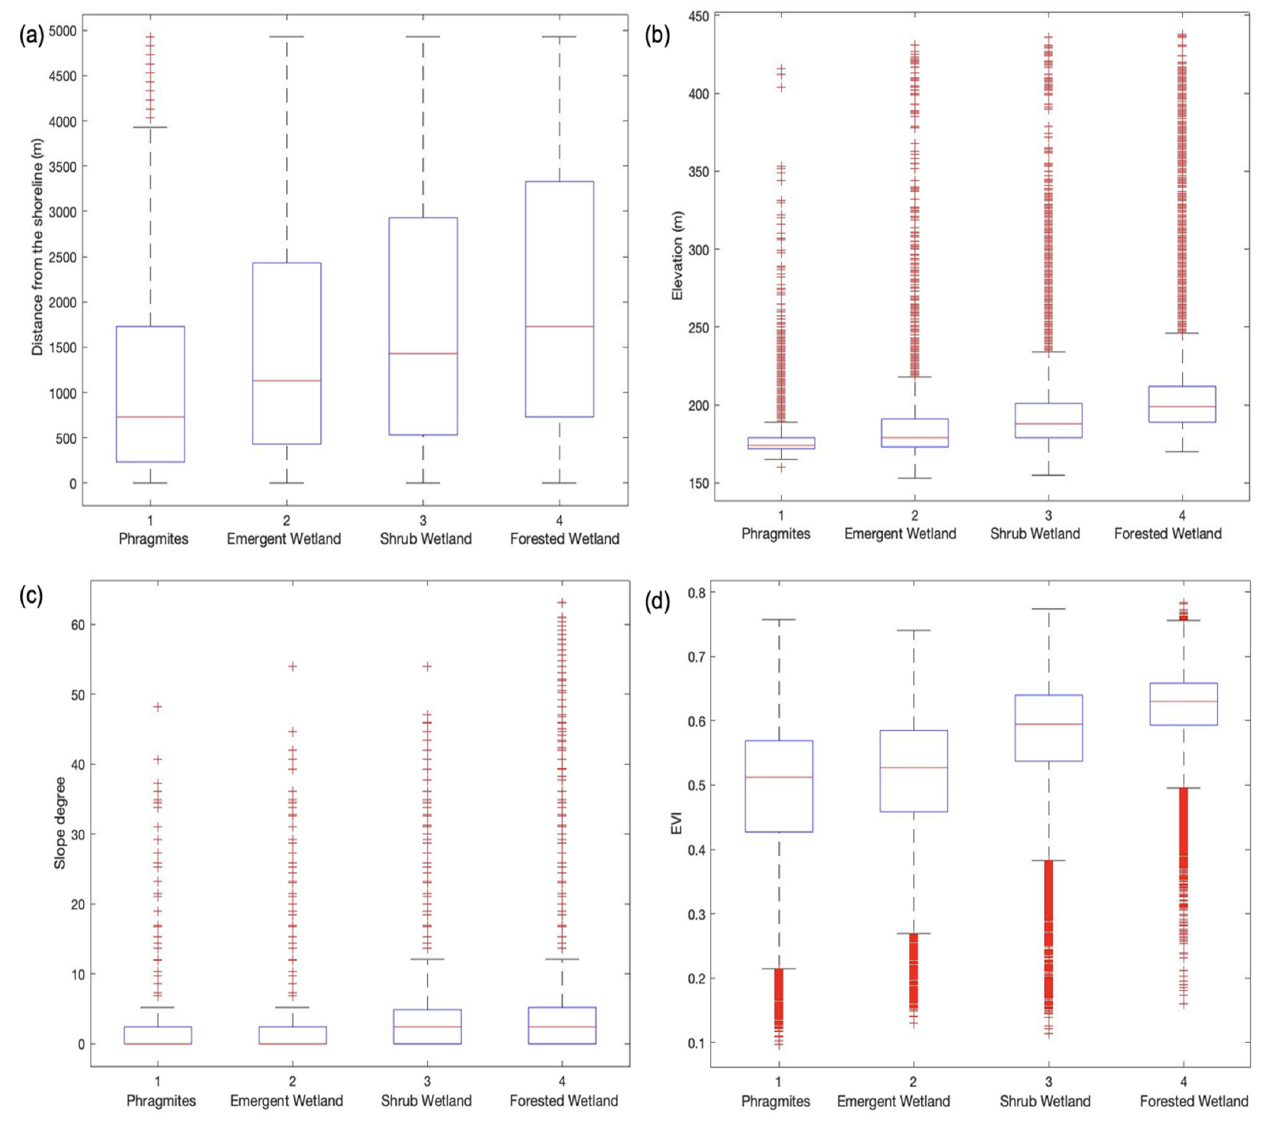
Figure 5. Wetland types as a function of: ( a ) distance from the shore; ( b ) elevation; ( c ) slope degree; ( d ) EVI. Table 1. Characteristics of each wetland type, where each value corresponds to the median of the group.